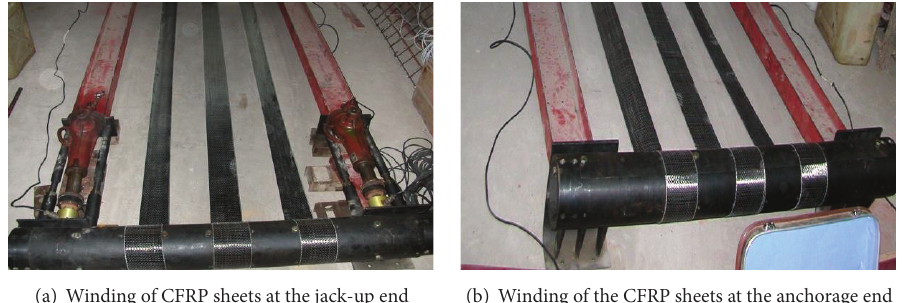
Figure 5: Photographs of the jack-up tensioning of multiple CFRP sheets.